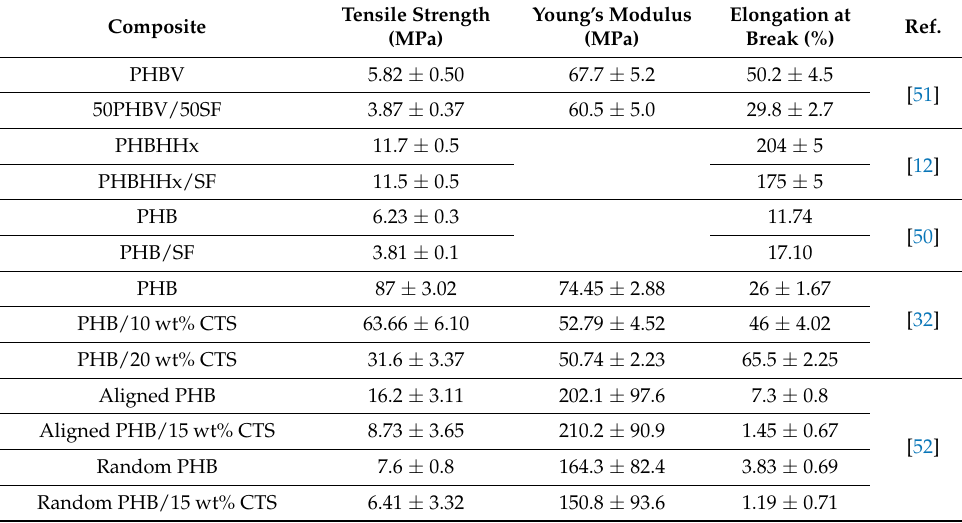
Table 1. Mechanical properties of the PHA-based